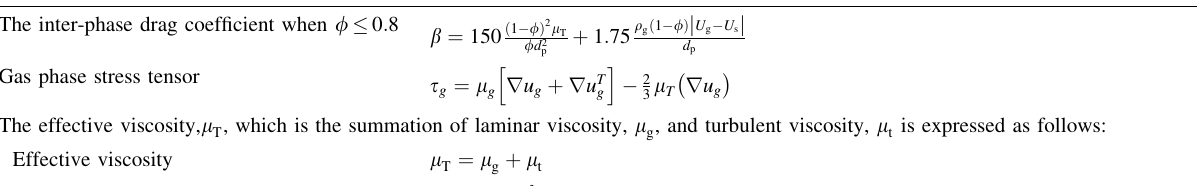
Table 8 Hydrodynamic mode 1 The inter-phase drag coefficient when / (cid:5) 0 : 8